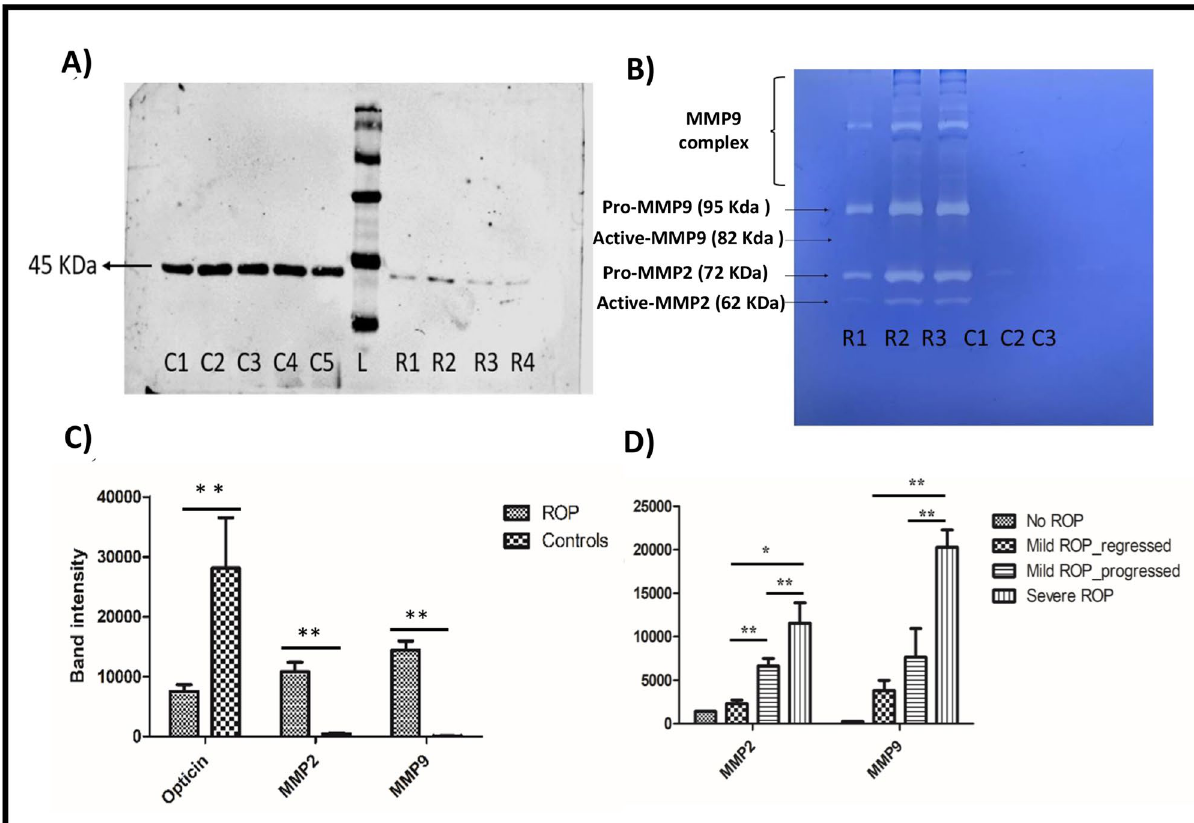
Figure 1. Representative image of ( A ) western blot of opticin levels in ROP patients and controls ( B ) representative gelatin zymography of vitreous from ROP and congenital cataract (controls) ( C ) quantification of opticin (45 K Da) levels in vitreous samples of ROP (n = 30) and control (n = 30) and MMPs in ROP (n = 11) and control (n = 11) ( D ) MMPs levels estimated in ROP tears samples by zymography in extended cohort, quantification of MMP9 and MMP2 estimated for severe ROP (n = 16), mild progressed to progressed ROP (n = 12), mild ROP to regressed ROP (n = 12), and no ROP premature controls (n = 18), ** p = 0.001, * p = 0.05; data represented as mean ± SEM, C, control vitreous; R, ROP vitreous; L, protein